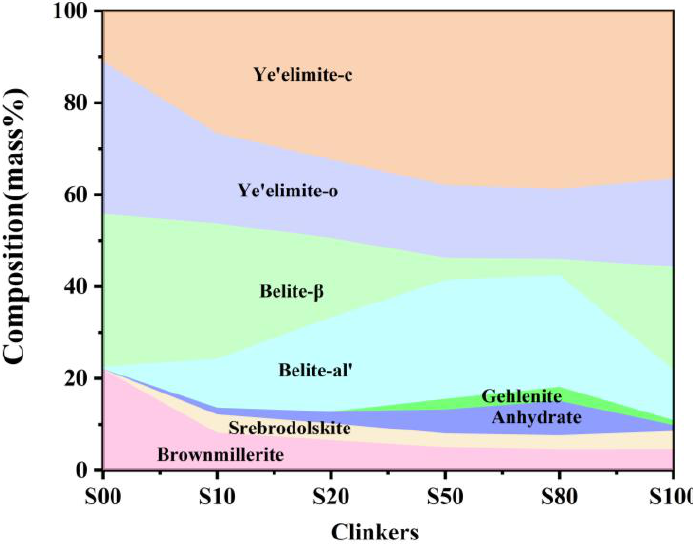
Figure 4. Phase evolution of clinkers S00 − S100.